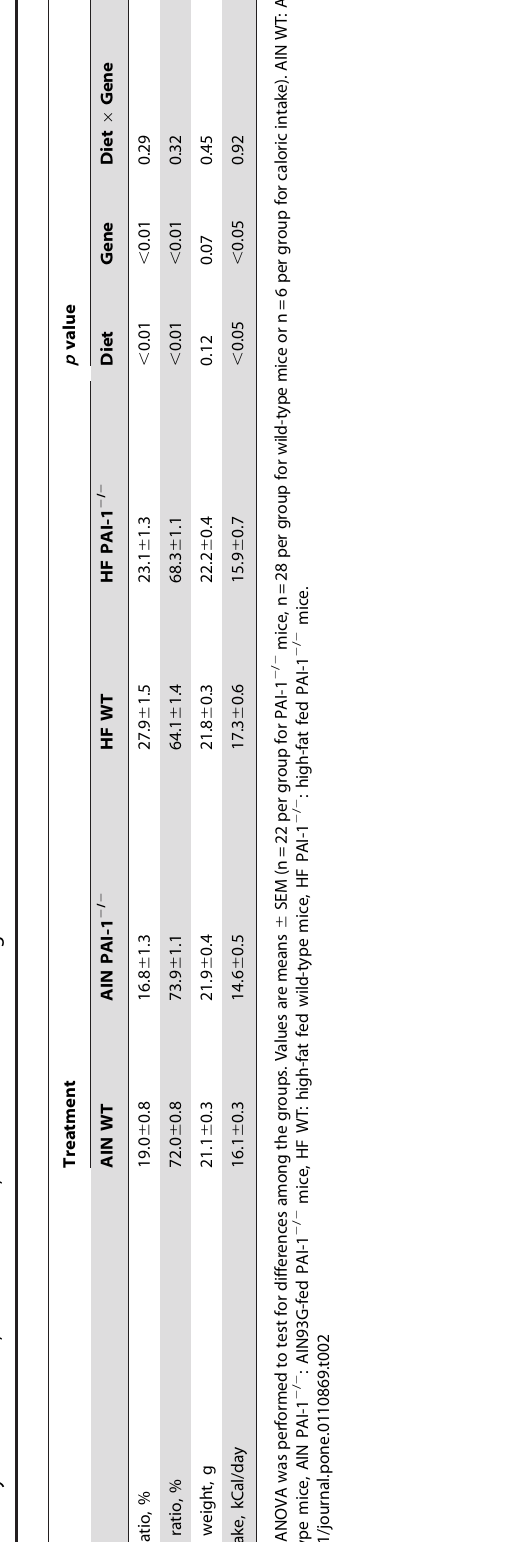
71% (high-fat vs. AIN93G: p , 0.01) (Table 4). Deficiency in PAI-1 increased plasma VEGF by 11% (PAI-1 2 / 2 vs. wild-type: p , 0.05) and TIMP-1 by 27% (PAI-1 2 / 2 vs. wild-type: p , 0.01) (Table 4). There were no differences in plasma concentrations of